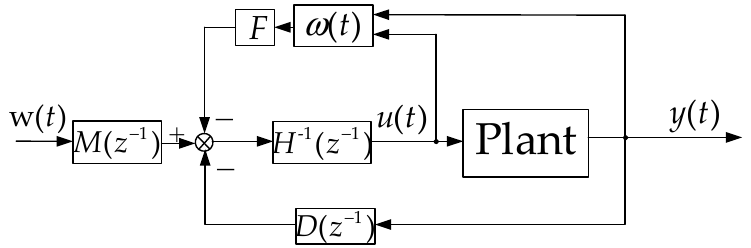
Figure 4. Linear feedback controller based on generalized minimum variance.